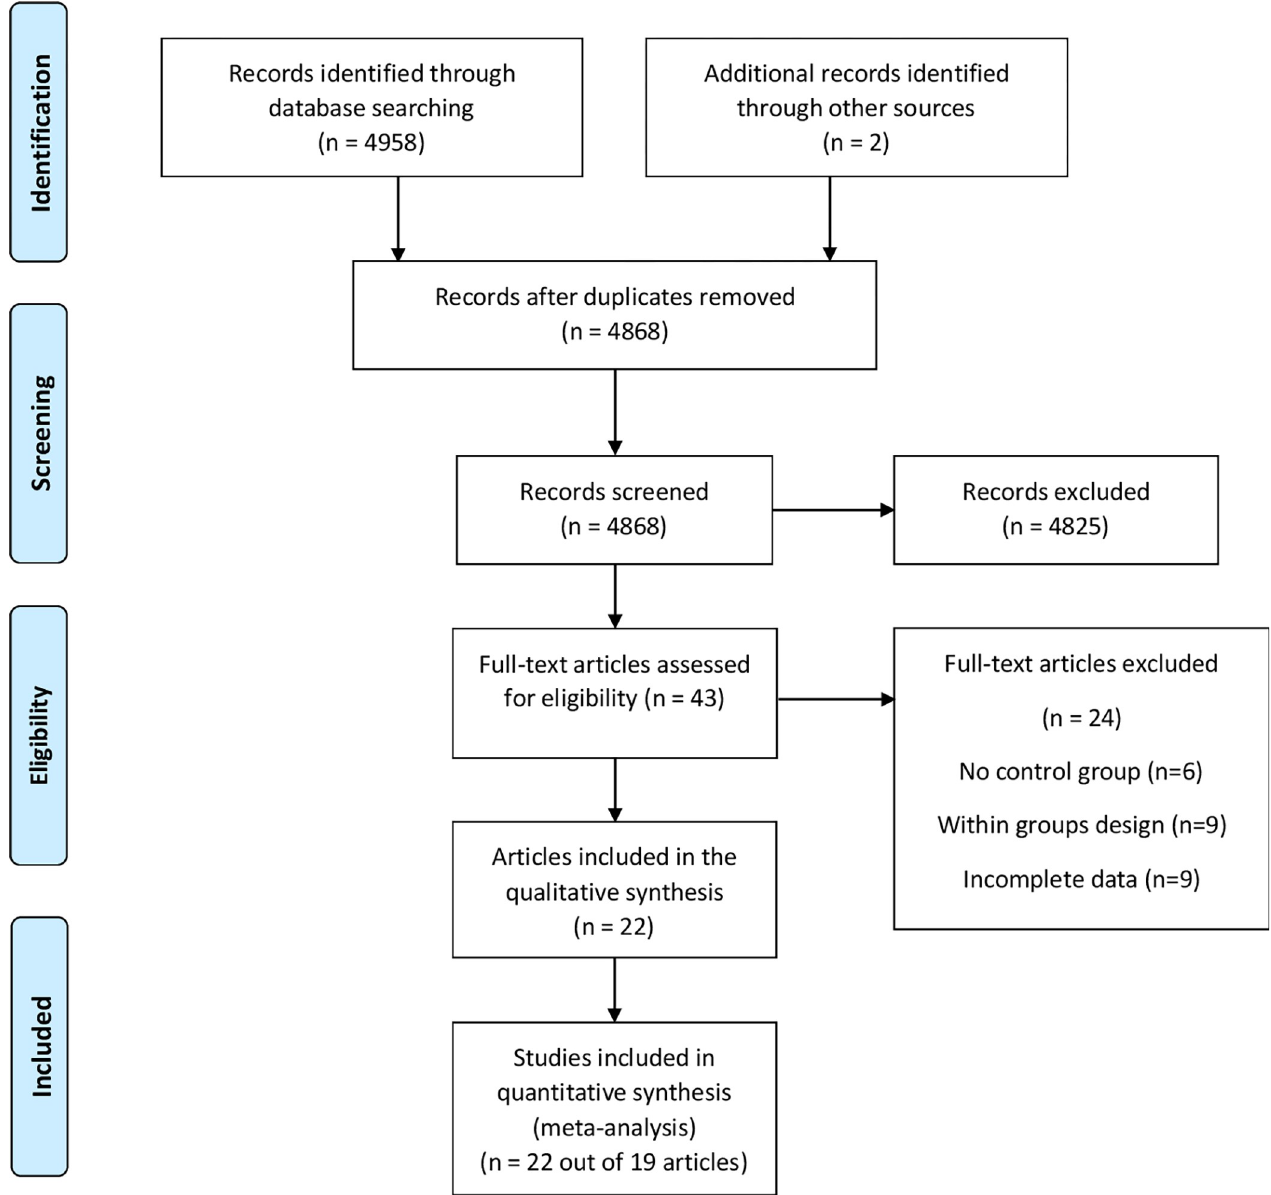
Fig 1. The PRISMA flow diagram of the literature search and selection